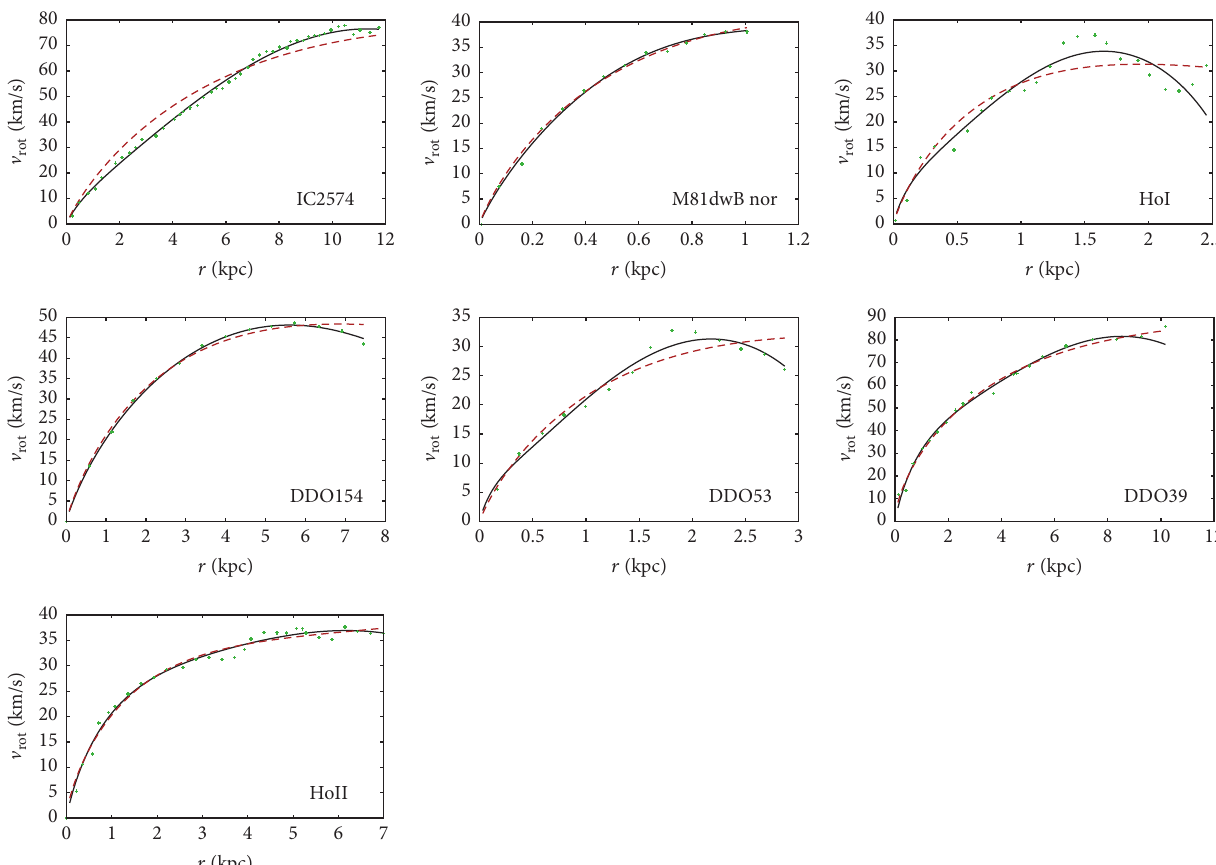
Figure 5: The best fit curves for the dwarf galaxy sample. The BEC + baryonic model (solid black curves) give a better fit in all cases than the NFW + baryonic model (dashed red lines). In both cases the fit was performed with the same baryonic model.